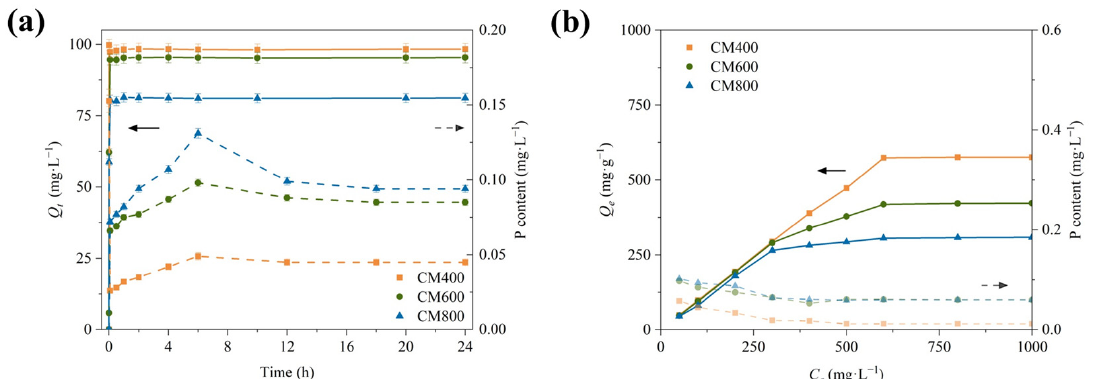
Figure 6. The relationship between the residual phosphorus content and Q t . ( a ) the relationship between the residual phosphorus content and Q t at different reaction times [initial concentration of Pb(II)] = 100 mg·L − 1 , [dosage] = 1 g·L − 1 , [temperature] = 25 °C, ( b ) The relationship between the residual phosphorus content and Q t in reaction with different initial concentrations, [reaction times] = 24 h, [dosage] = 1 g·L − 1 , [temperature] = 25 °C.